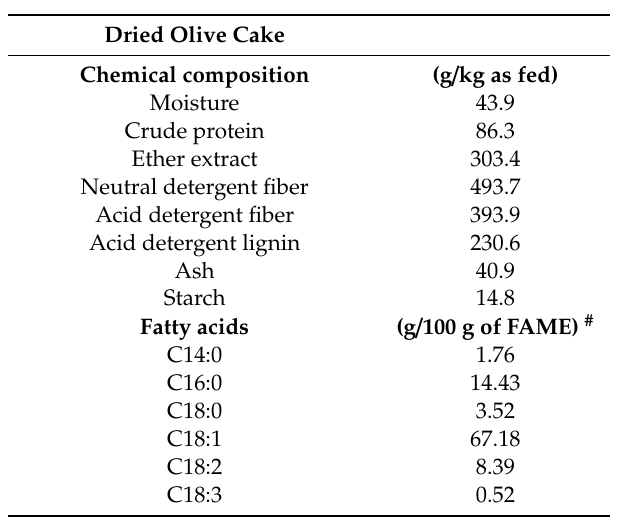
Table 2. Chemical and acidic composition of the dried olive cake used in the